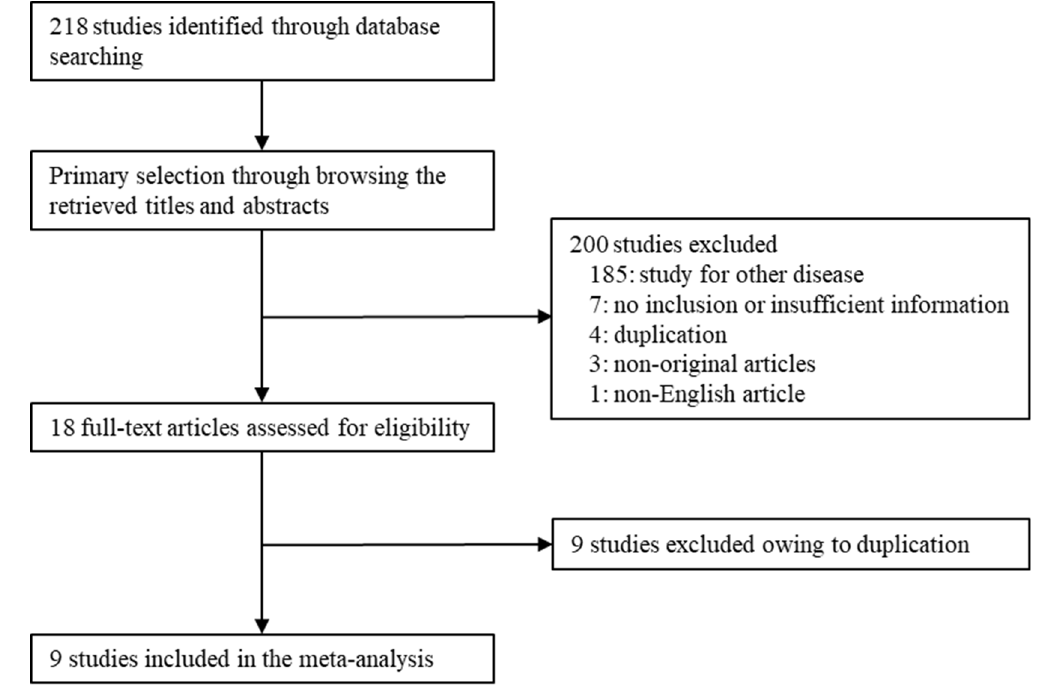
Figure 1. Flow chart of the literature search and selection methods. Table 1. Main characteristics of the eligible studies.